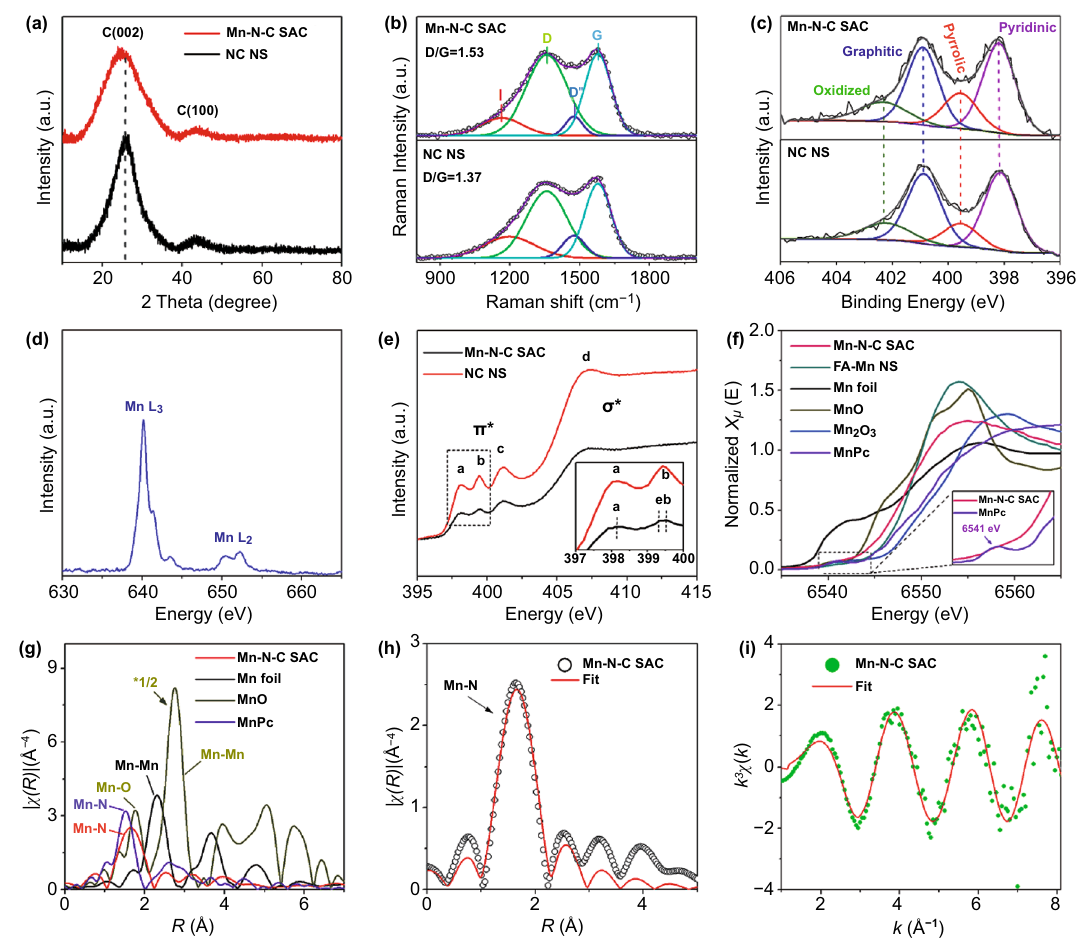
Fig. 2 a PXRD patterns, b Raman spectra, c N 1s XPS spectra of Mn–N–C SAC and NC NS. d Mn L‑edge XAS spectrum of Mn–N–C SAC. e N K‑edge XAS spectra of Mn–N–C SAC and NC NS. f XANES of Mn–N–C SAC, FA‑Mn NS and the standard references. Inset is the enlarged XANES spectra of Mn–N–C SAC and MnPc from the dashed rectangle area. g FT‑EXAFS spectra of Mn–N–C SAC and the standard refer‑ ences. h, i FT‑EXAFS curve fitting of Mn–N–C SAC in R and k